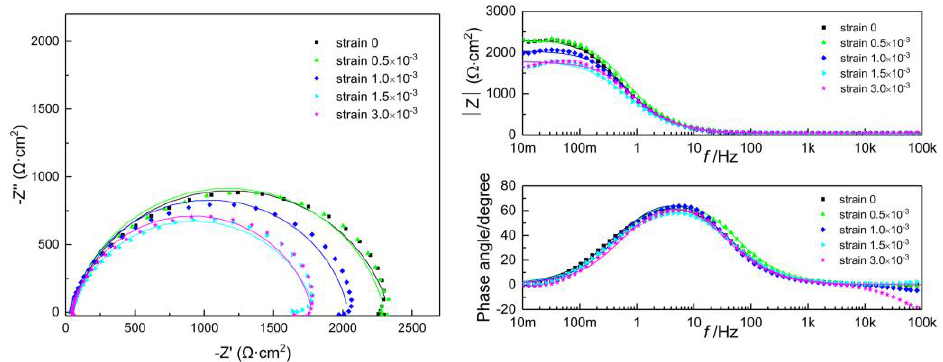
Figure 6. Nyquist and Bode plots of X80 steel sample in NS4 solution without DC currents under different applied strains.